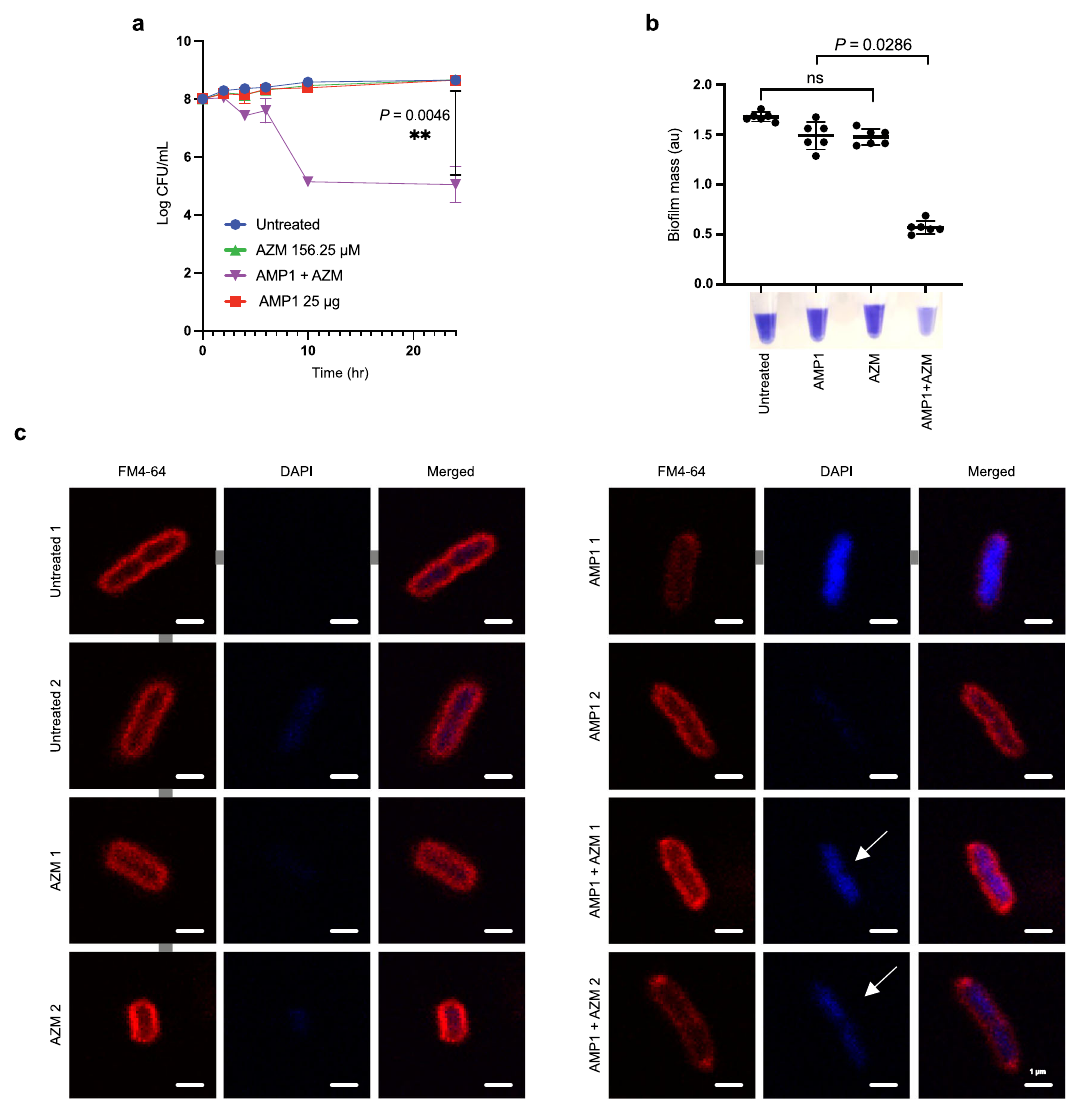
Fig. 6 | Puri fi ed peptides synergize with AZM by increasing the membrane permeability of carbapenem-resistant E. coli PI-7. a Time-kill curves and b , prevention of bio fi lm formation assay for drug-resistant E. coli PI-7. Nearly 10 8 CFU/mLof E.coli PI-7inthebacteriologicmediumCa-MHBweretreatedwithAMP1 (25 µ g/mL), AZM (156.25 µ M) alone or in combination for 24h. For time-dependent killingcurveassay,CFU/mLwasenumeratedat2,4,6,10and24h.Incaseofbio fi lm assay, 24h treated culture was stained with 1% [v/v] crystal violet and results are expressed as bio fi lm mass, in arbitrary units (au). Data are means±SD and repre- sent the average of duplicates from 3 independent experiments. P =0.0046, one- wayANOVA,Dunnett ’ stestand P =0.0286,two-tailedMann-Whitneyranksumtest. c Overnight culture of E. coli PI-7 were diluted to 3 ×10 8 CFU/mL in Ca-MHB and